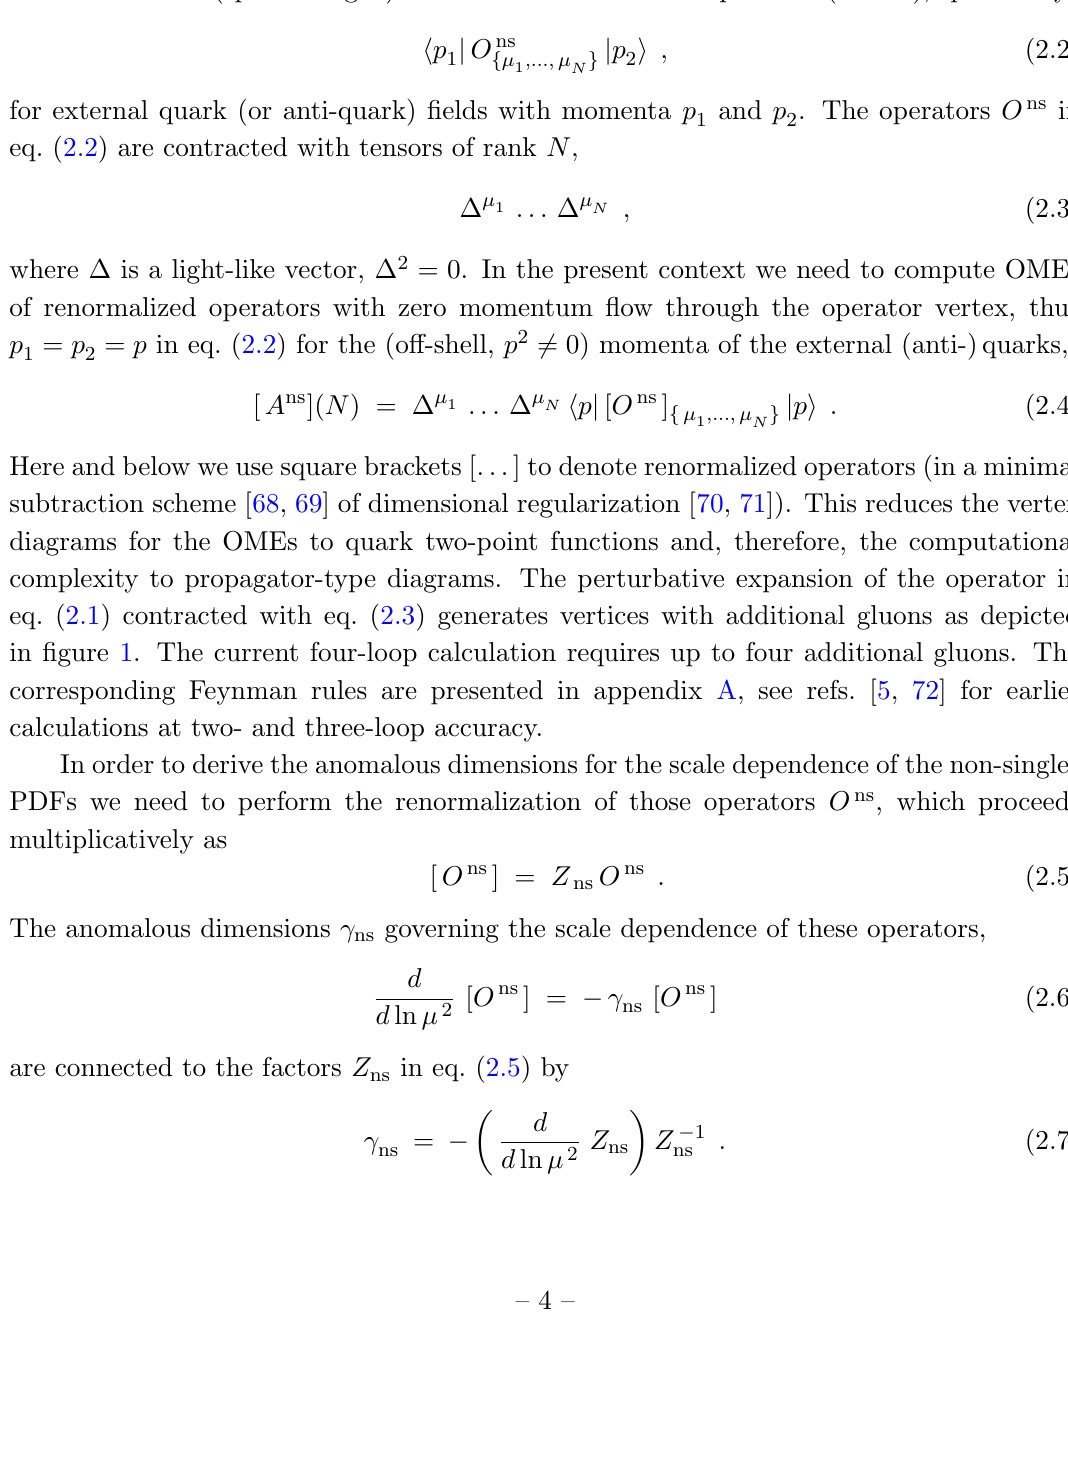
Figure 1 . Vertices with additional gluons arising from the operators O ns QCD. Vertices with up to L gluons need to be considered at L loops at Mellin moments N > L